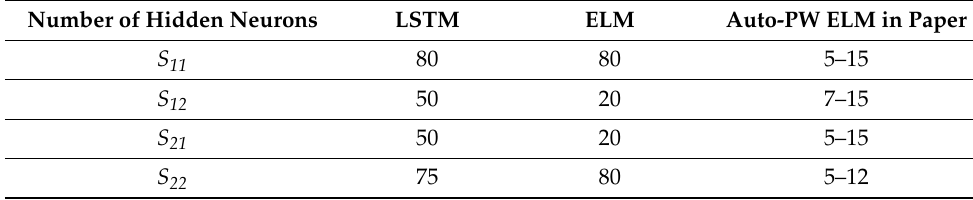
Table 2. Comparison of various approaches in terms of the number of hidden